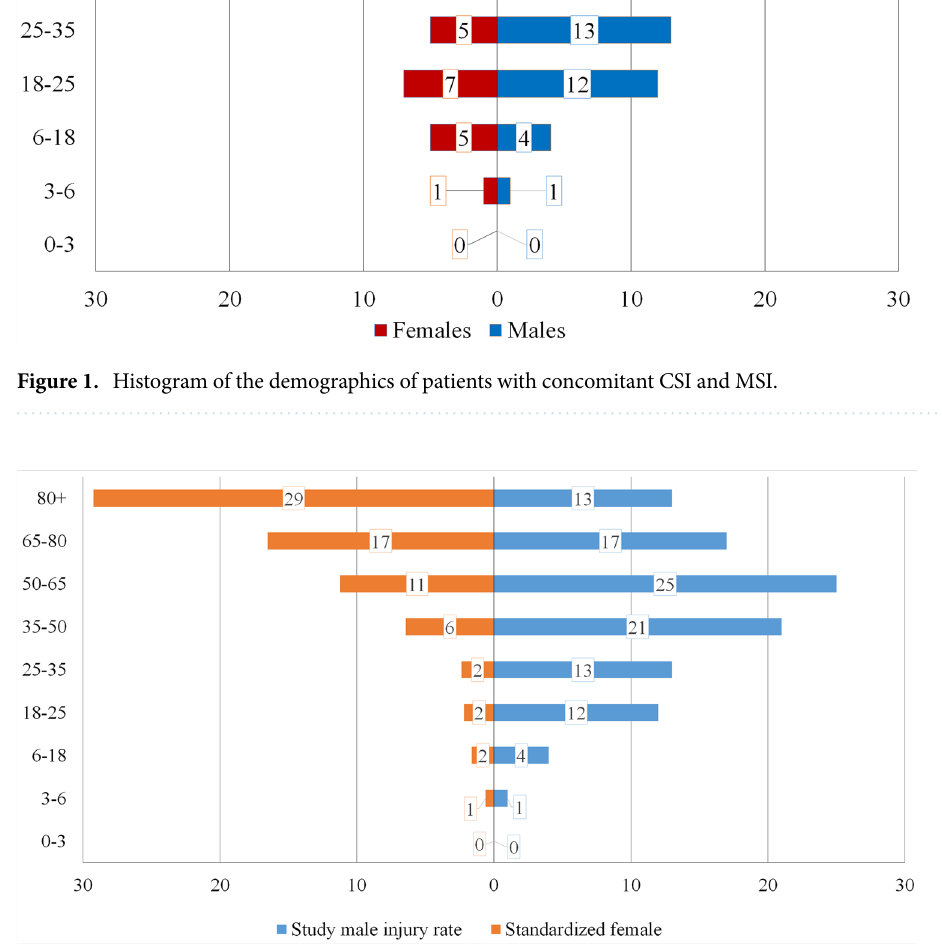
Figure 2. Standardized histogram based on the population registry report released by the Authority of the City of Dortmund of the patients with concomitant CSI and MSI. The age grouping in Figs. 1 and 2 is based on the official demographic registry report for